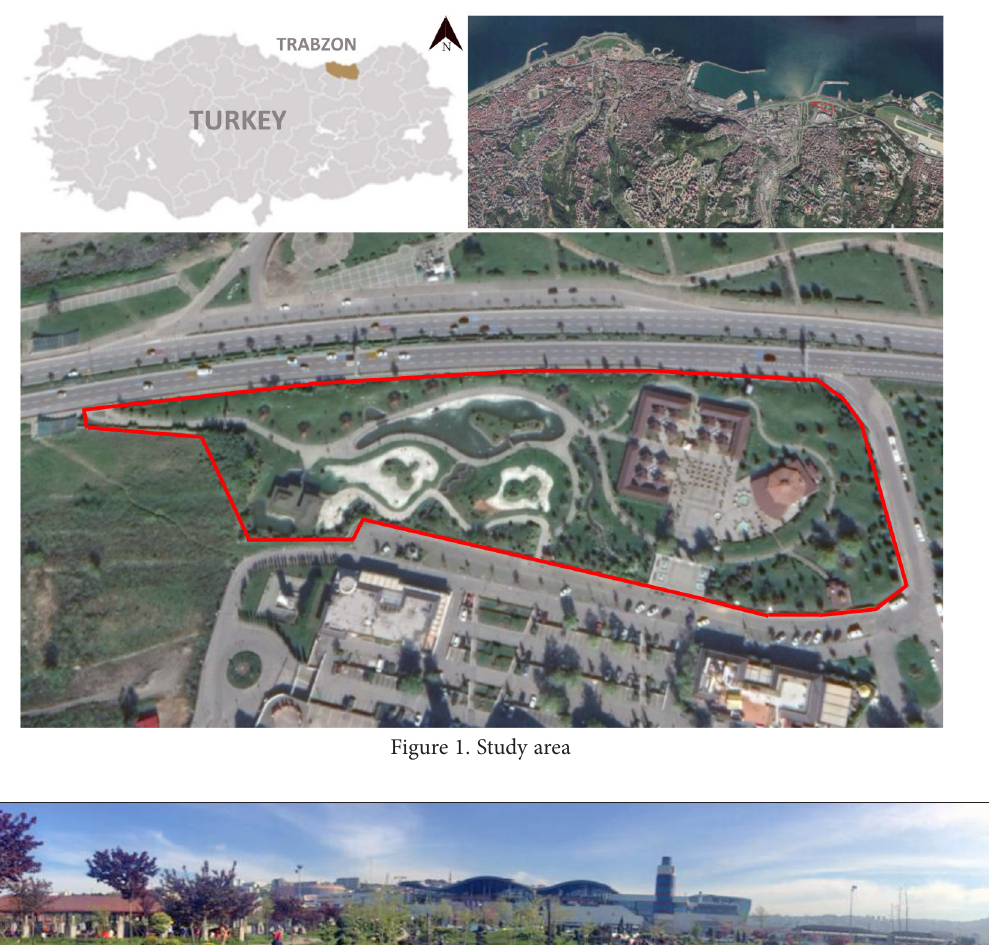
Figure 2. Panoramic view of the